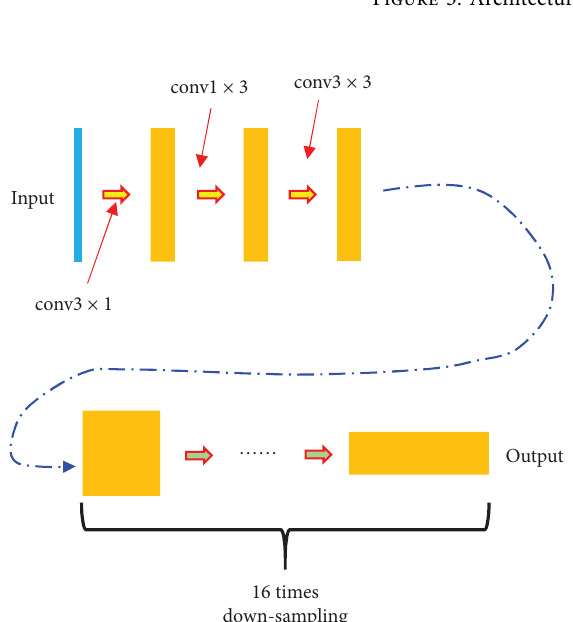
Figure 4: Architecture of feature extraction